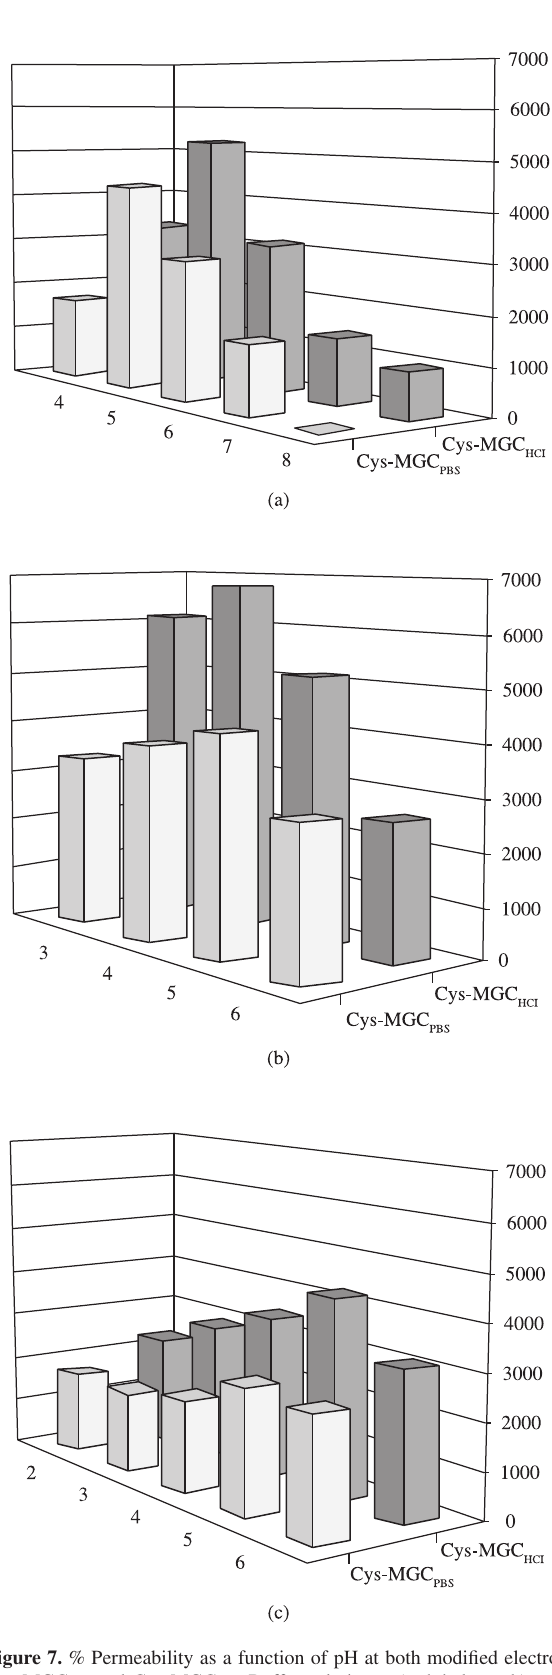
Figure 7. % Permeability as a function of pH at both modified electrodes, Cys-MGC and Cys-MGC . Buffer solutions: a) phthalate ; b) acetate PBS HCl and c) phosphate . where Ifilm and Ibare are the voltammetric peak currents recorded at the modified electrode and the bare GC,